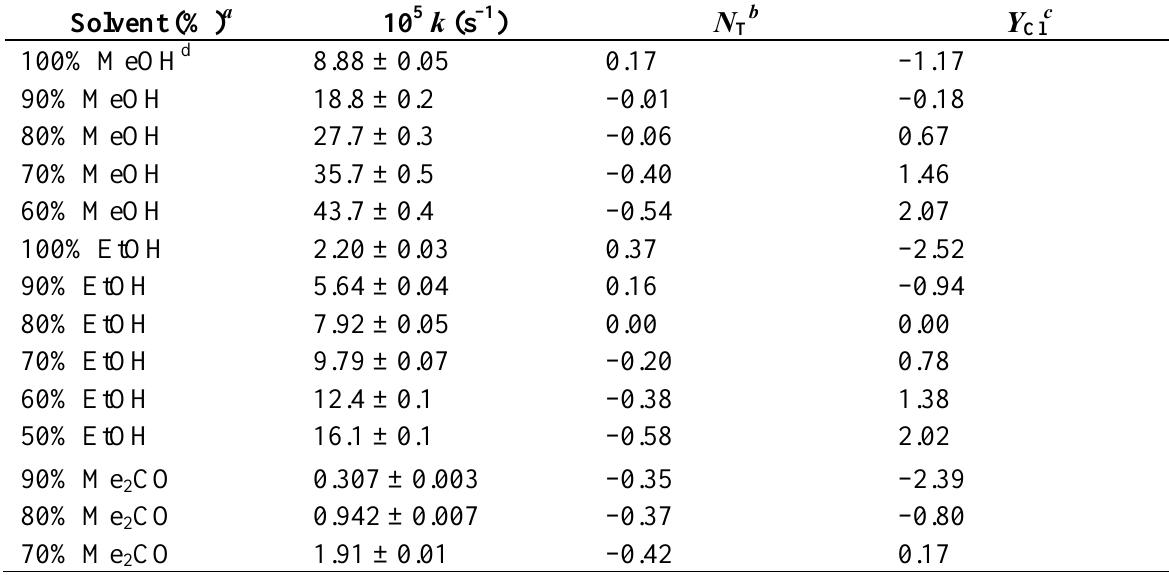
Table 1. First-order rate coefficients for the solvolysis of n -propyl chloroformate in pure and binary solvents at 25.0 ºC together with the appropriate solvent ) and solvent ionizing power ( Y ) nucleophilicity ( N T Cl